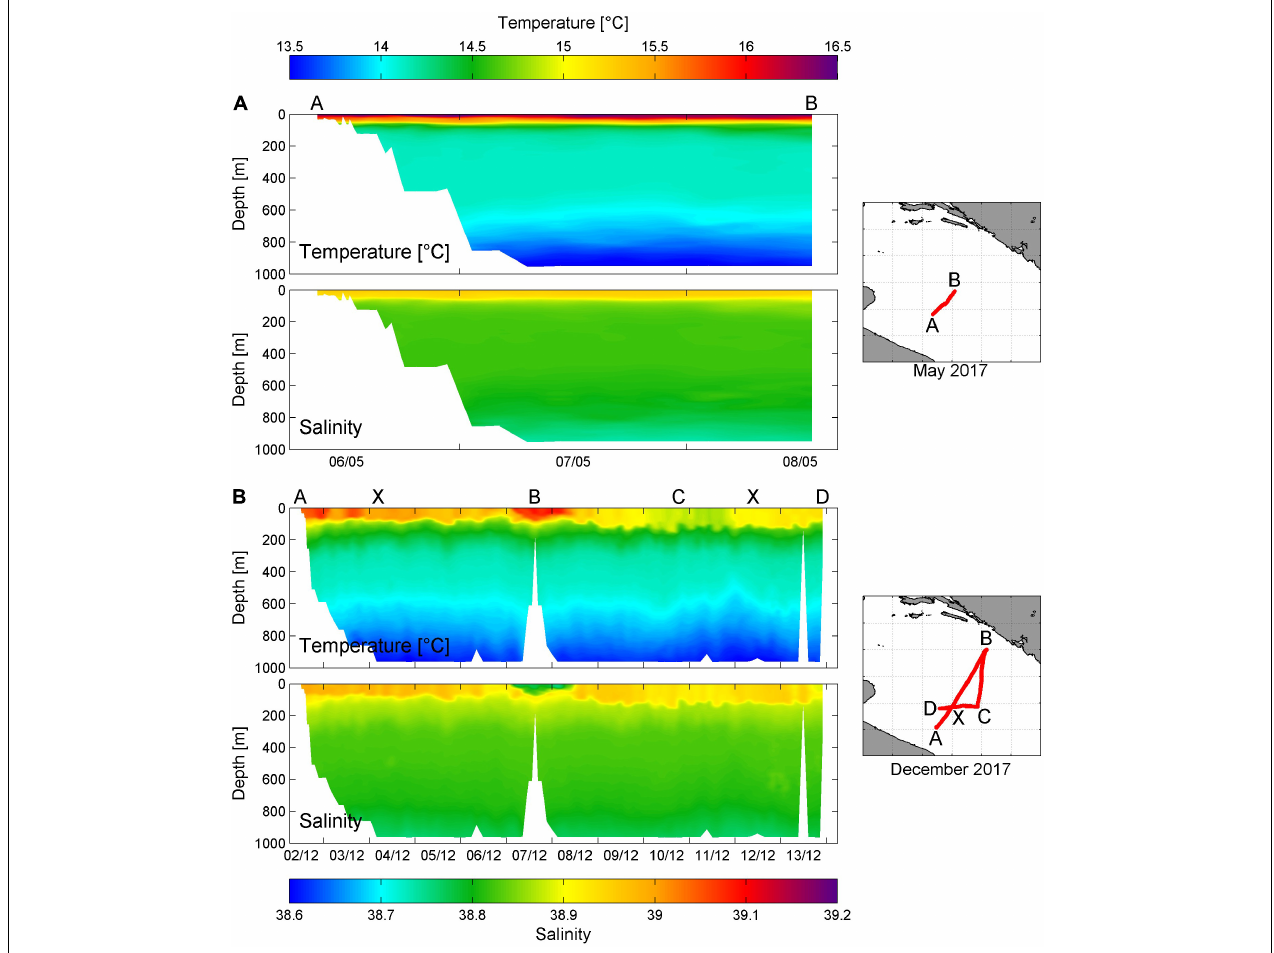
FIGURE 4 | (A) Glider temperature and salinity transects in the in the Southern Adriatic between 6 and 8 May 2017 (left panels) and the corresponding trajectory of the glider (right panel). (B) As in panel (A) except for glider transect from 2 to 13 December 2017. The crossing point between the “A–B” and “C–D” segments of the December 2017 glider mission is indicated by letter